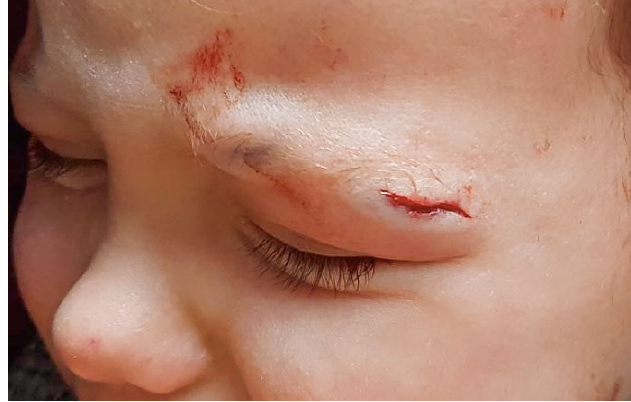
Figure 1 (The photograph is published with an informed consent from the